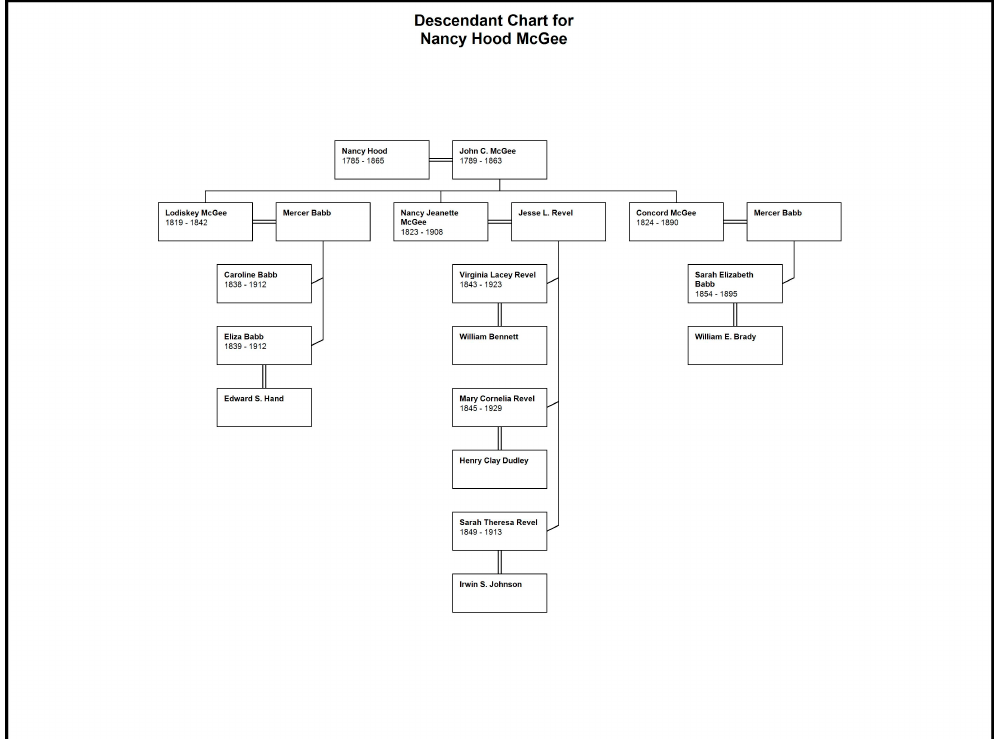
Figure 1. Selected descendants of Nancy Hood McGee (1785–1865).